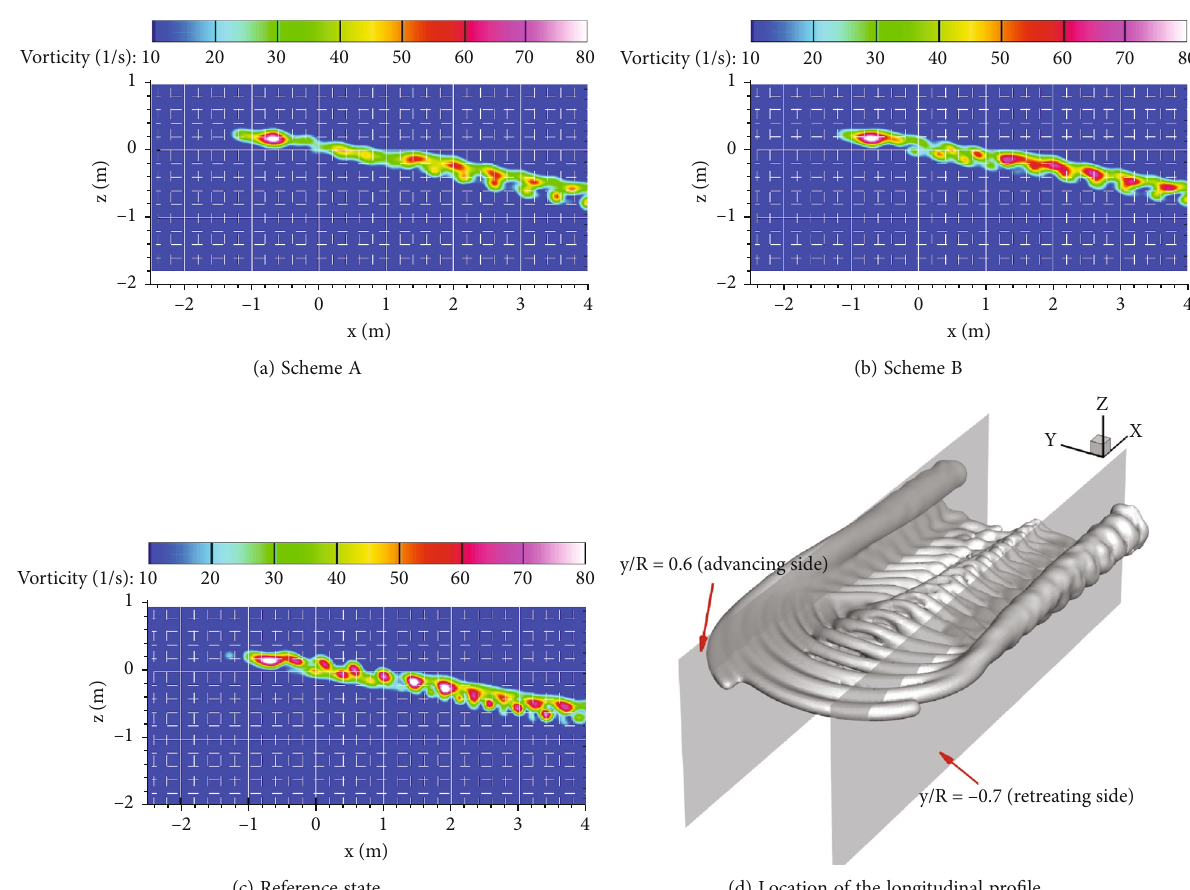
Figure 15: Wake vorticity cloud plot of the y = 0 : 6 R longitudinal pro fi le on the advancing side of the sample ECR.